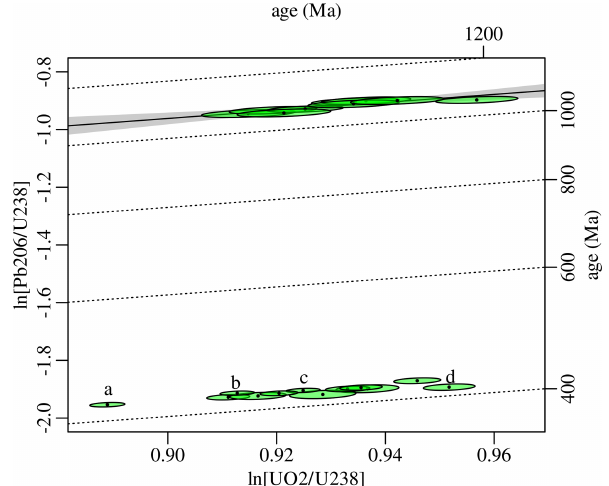
Figure 8. Calibration curve of the Cameca data using 91500 zircon as a reference material (top half of the plot) and Temora2 zircon as a sample (bottom half). a – d mark four Temora2 aliquots whose uncertainty budget is explored in Table